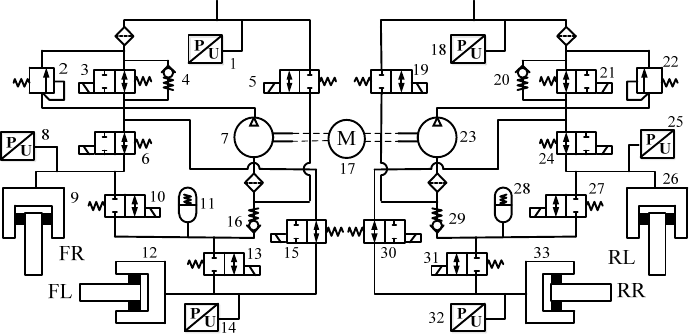
Figure 3. The schematic diagram of hydraulic regulating unit. 1, 8, 14, 18, 25, 32—pressure sensor; 4, 16, 20, 29—one-way valve; 2, 22—relief valve; 3, 21—isolation solenoid valve; 5, 19—adjusting unit inlet solenoid valve; 7, 17, 23—electric pump; 6, 15, 24, 30—wheel cylinder inlet solenoid valve; 10, 13, 27, 31—wheel cylinder outflow solenoid valve; 11, 28—low pressure accumulator; 9, 12, 26, 33—wheel cylinder assembly.